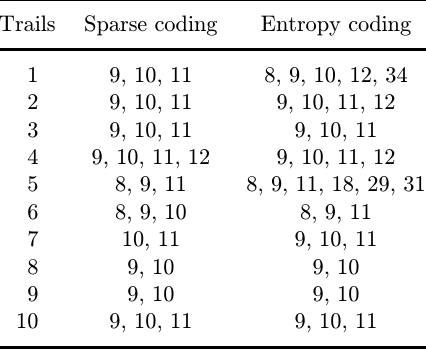
Table 1. Ensemble neurons identi¯ed by sparse coding and entropy coding.